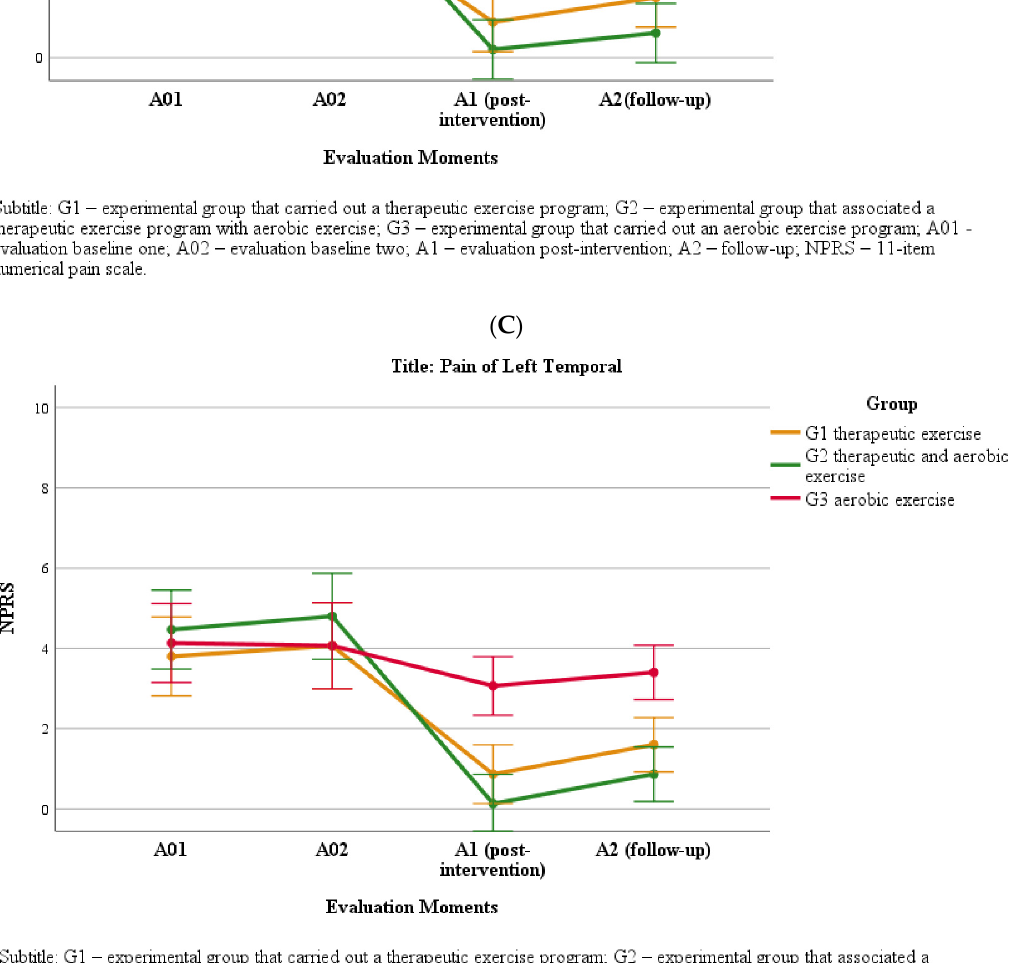
muscle of both sides (left and right). In resting position, the average sEMG was calculated